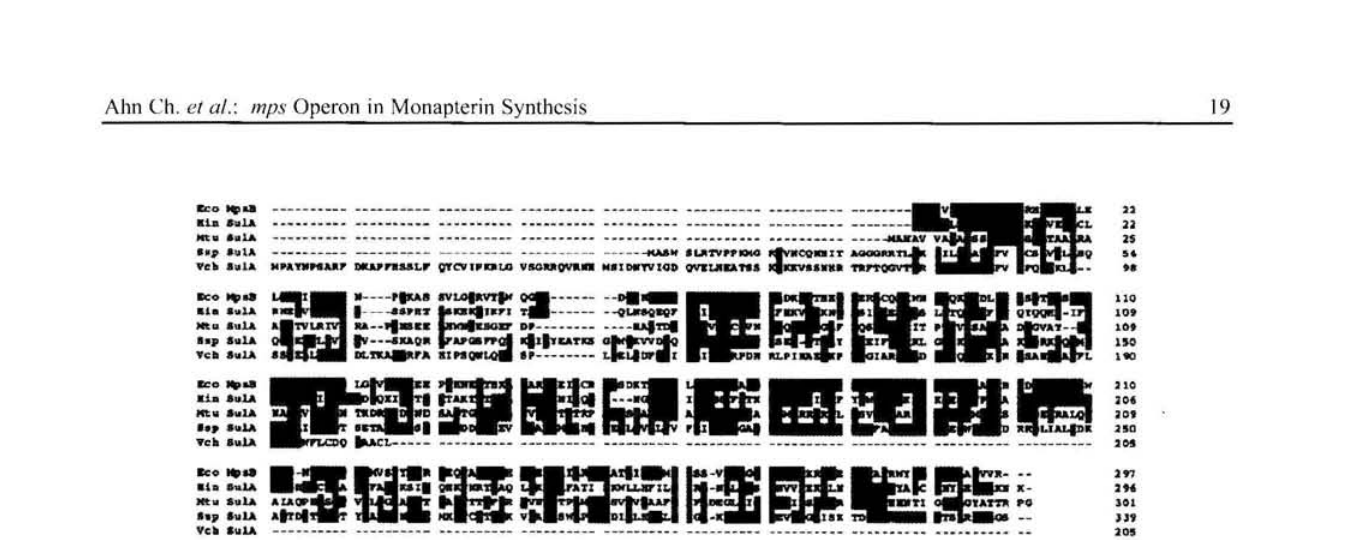
Figure 5. Alignment of the prcdicted amino acid sequence of MpsB with the SulA proteins of Haemophilus influenzae, Mycobacterium tuherculosis, Synechocystis sp., and Vibrio cholerae. Black boxes indicate amino acid